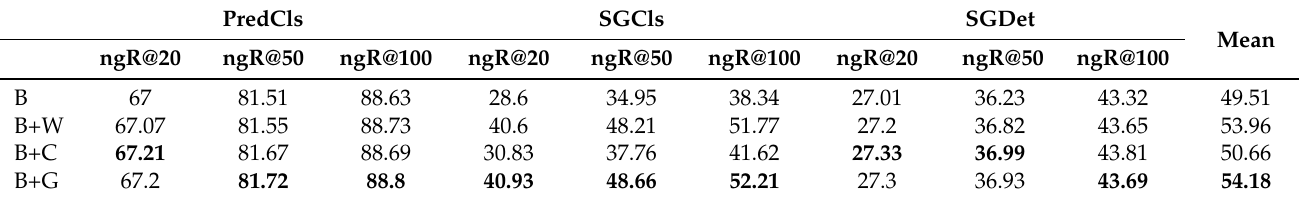
Table 5. Influence of different types of external knowledge on